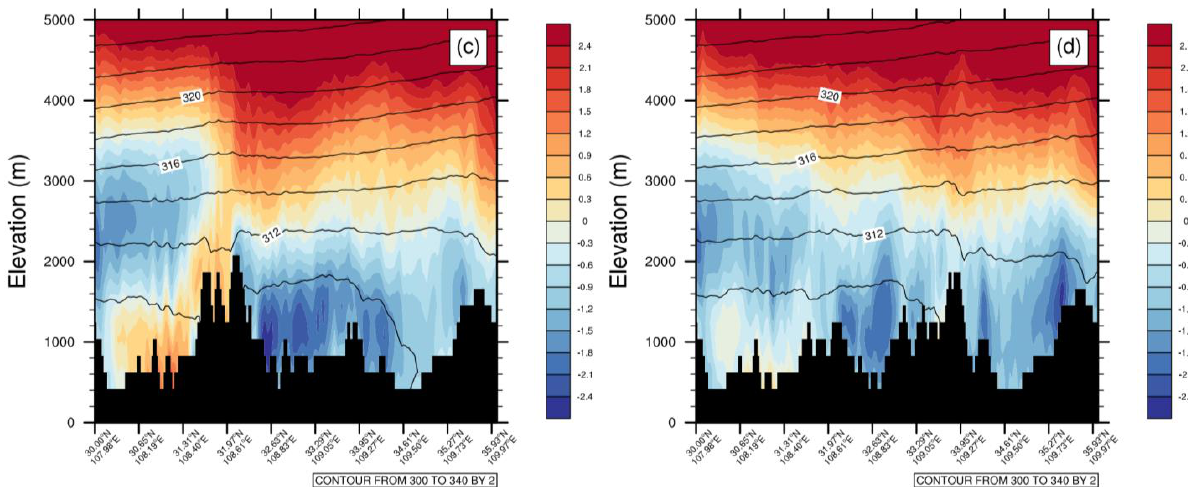
Figure 13. Vertical cross sections of vertical velocity of wind (m s −1 , color filling) and potential temperature (K, contour line) along the blue lines in Figure 1 of ( a ) CTRL, ( b ) LowQD, ( c ) LowQ, and ( d ) LowD on an average on 09:00 UTC (local time of 16:00, afternoon) during the whole simulated time period.